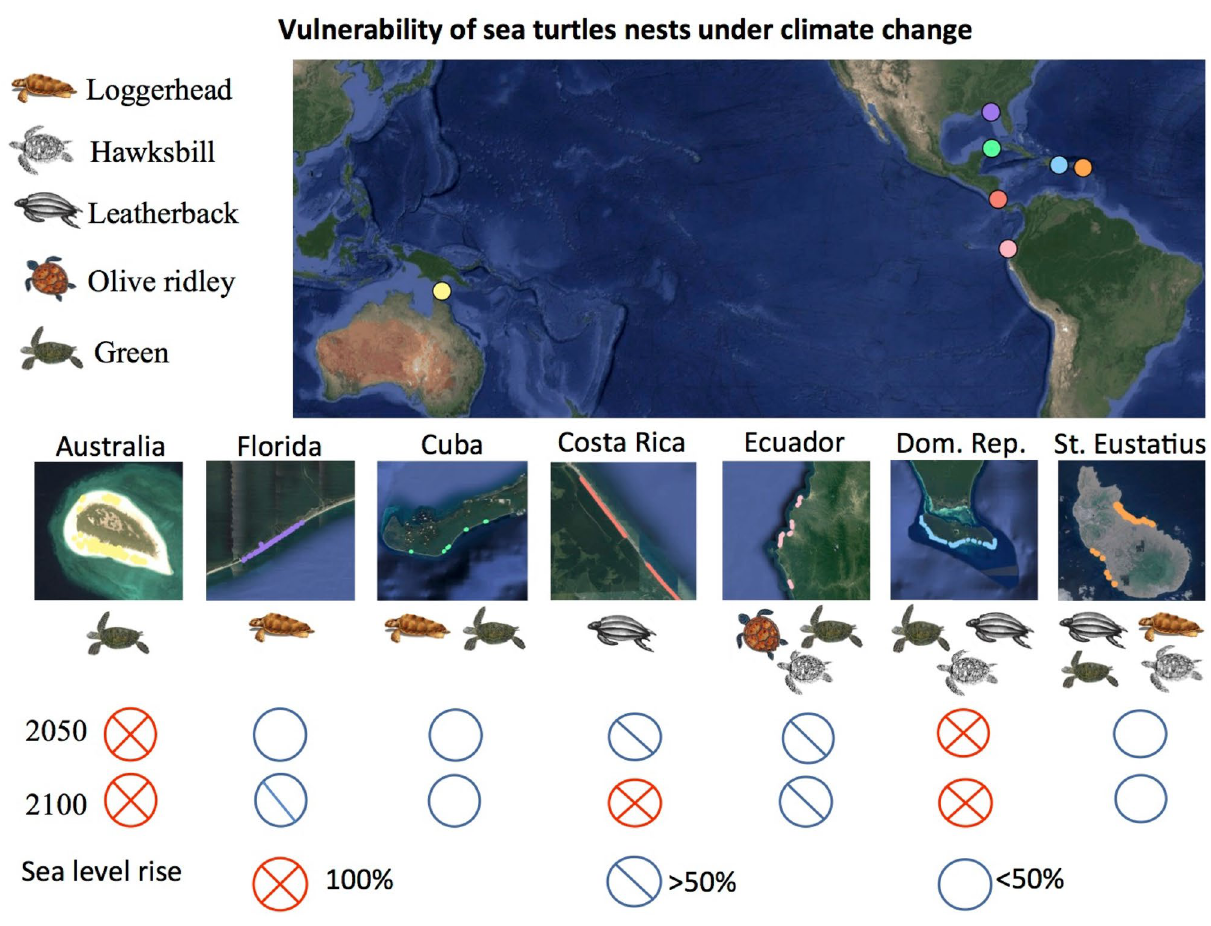
Figure 1. Vulnerability of sea turtle nests under sea level rise at IPCC’s RCP 4.5. Seven study sites at sea turtle rookeries spanning countries in the Caribbean Sea, Gulf of Mexico and Pacific Ocean, with five species represented. In the Caribbean and Gulf of Mexico: Mondonguillo beach, Costa Rica; Guanahacabibes peninsula, Cuba; Saona Island, Dominican Republic; Zeelandia, Turtle, Kay bay, Tumbledowndick, Crooks and Oranjebaai beaches, St Eustatius; and St George Island, Florida, USA. In the Pacific Ocean: Coast of Ecuador; and Raine Island, Australia. Map Data: Google Earth and free